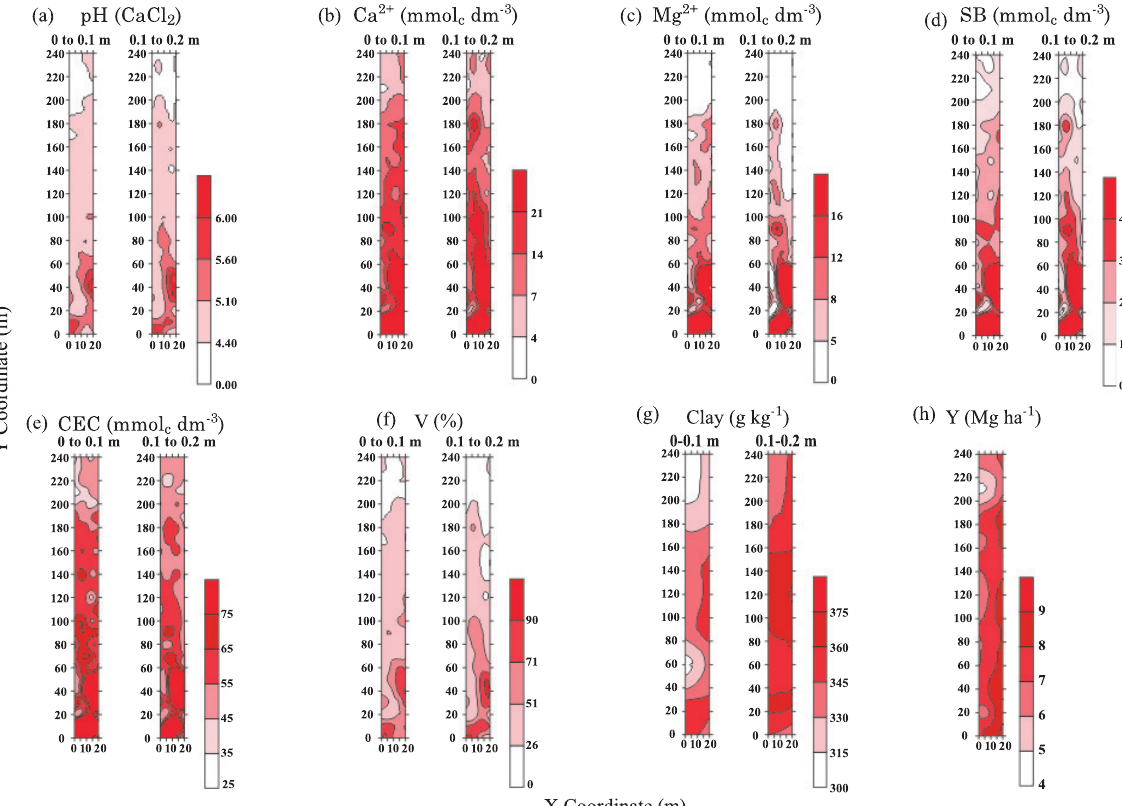
squares.Figure 3. maps of ph (a), Ca 2+ content (b), mg 2+ content (c), SB (d), CeC (e), V (f), clay content (g) and Y (h). SB: sum of bases; CeC: cation exchange capacity; V: percentage of soil base saturation; Y: corn